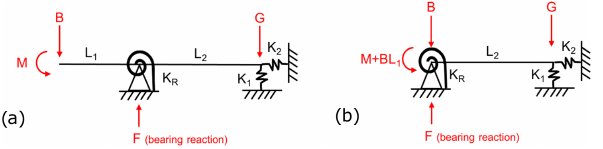
Figure 9. (a) Analytical model for single-main-bearing set-up with torsional spring to include moment reactions. The overall model consists of one in the horizontal and one in the vertical plane. (b) Simplified analytical model with torsional spring.